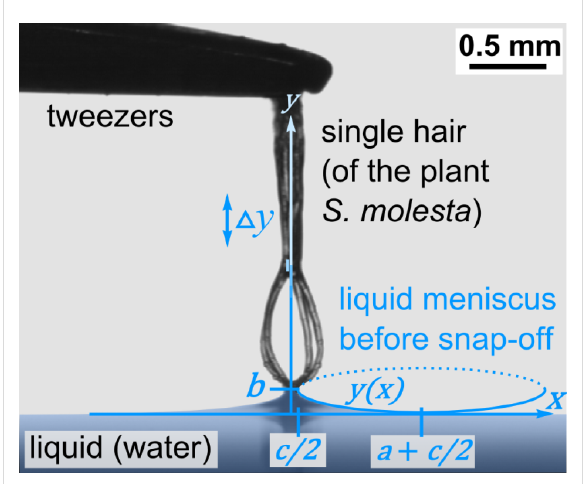
Figure 2: Meniscus immediately before snap-off. The profile can be fit by an elliptical function (Equation 1, y ( x )) with fitting parameters a , b , c as shown above. From Equation 2, the surface area of the meniscus is derived, enabling calculation of the energy required to build the meniscus (Equation 3) and the maximum pulling force on the trichome (Equation 4) equivalent to the water adhesion force of the trichome tip. By evaluating the elongation of the trichome, Δ y , the elastic properties are